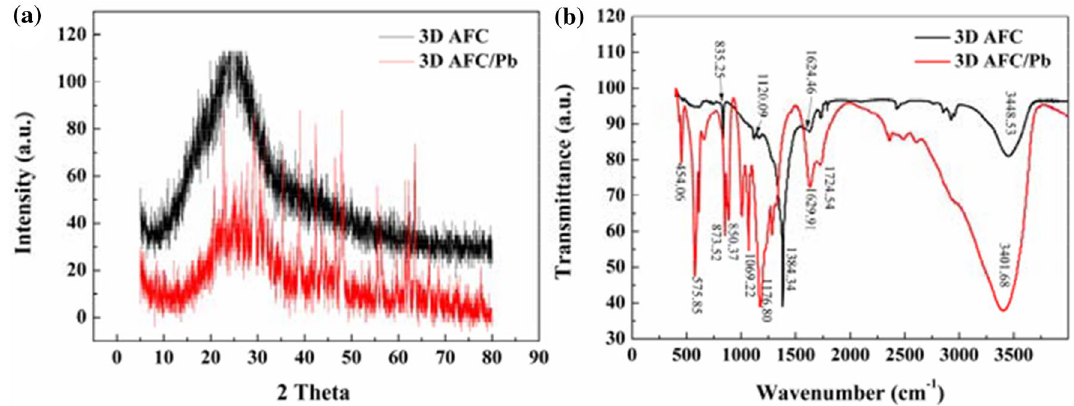
Fig. 2 The XRD ( a ) and FTIR ( b ) results of 3D AFC before and after Pb2 + adsorption